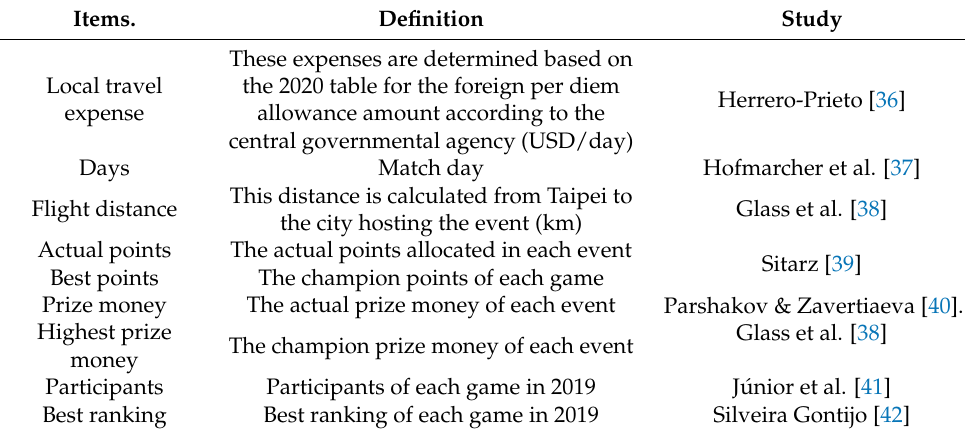
Table 2. Operational